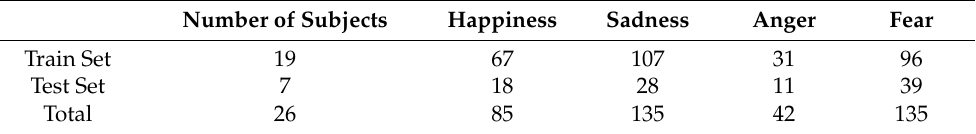
Table 2. Statistics of the